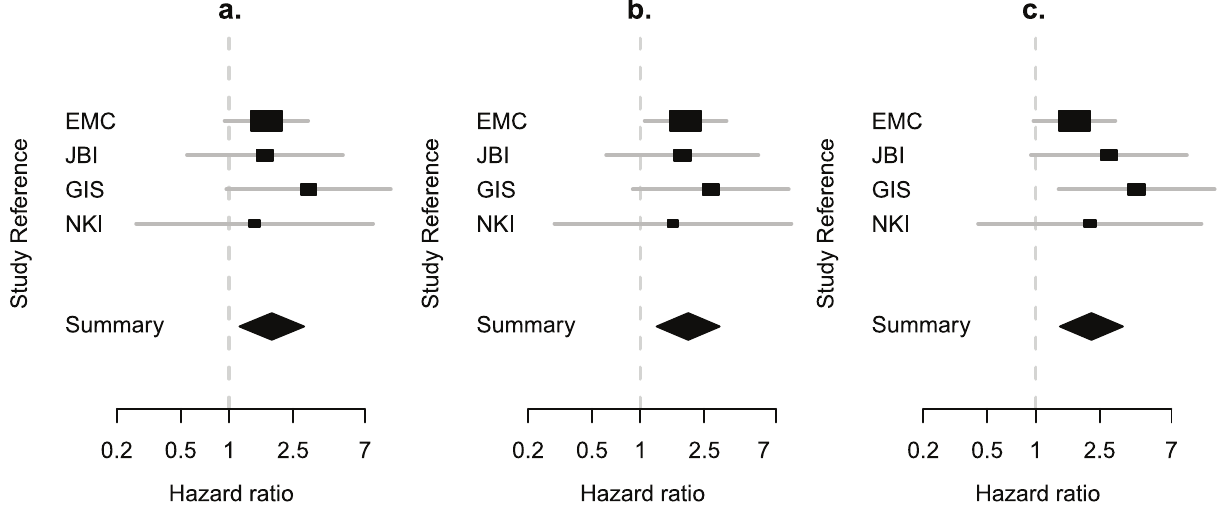
Figure 2. Prognostic power of IHC-based and expression-based ER status. Meta-analysis in four cohorts suggests that ER-statuses based on expression profile indicates stronger prognostic power than IHC based ER-status. The hazard ratios were estimated based on ER status determined by IHC (a.), ESR1 expression (b.) and 23-gene signature (c.), separately.